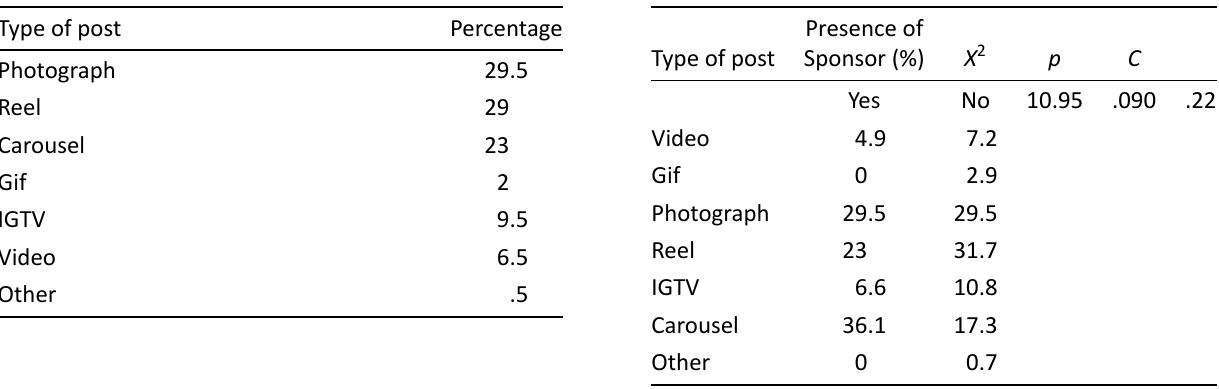
Table 3. Type of format of the posts. Table 4. Presence of brands or